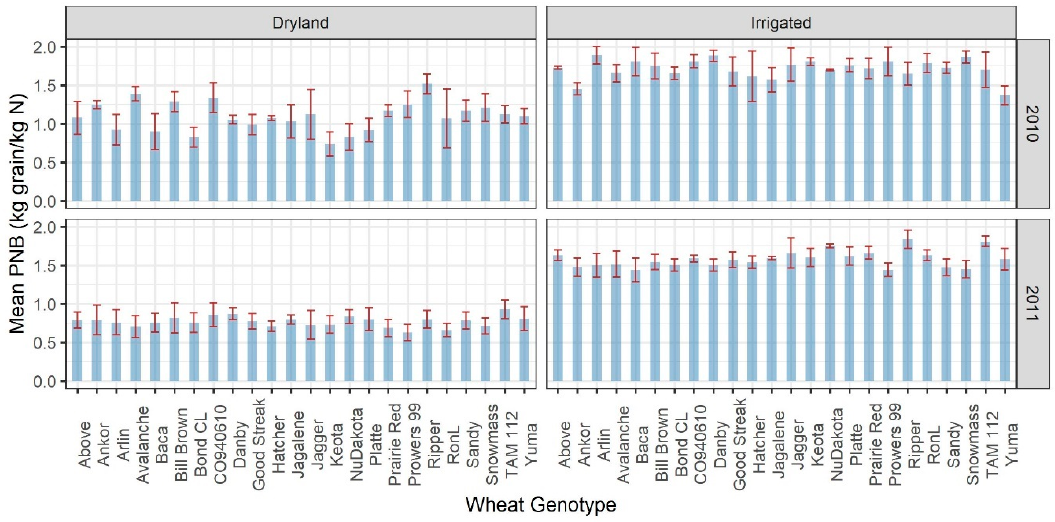
Figure 3. Mean nitrogen use efficiency as the partial nitrogen balance (PNB) across 24 winter wheat genotypes for ( top - left ) dryland in 2010, ( top - right ) irrigated conditions in 2010, ( bottom - left ) dryland in 2011, and ( bottom - right ) irrigated land in 2011. Error bars are the standard errors.